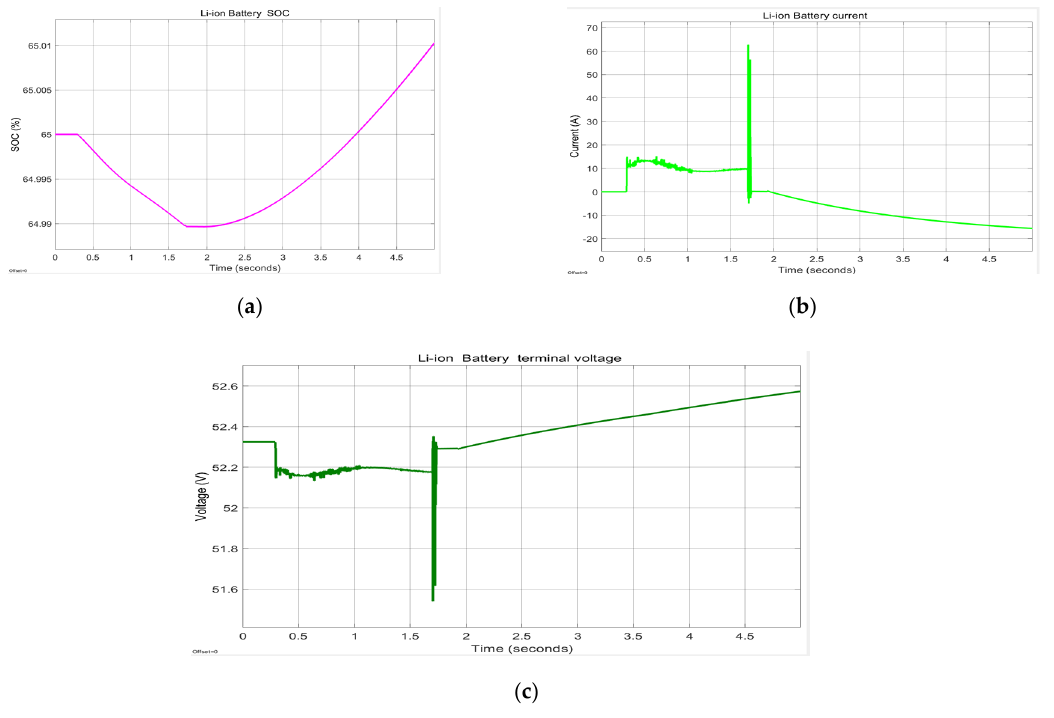
Figure 33. Li-ion battery supplying the PMDCM; ( a ) Li-ion battery SOC; ( b ) Li-ion battery current; ( c ) Li-ion battery terminal voltage.